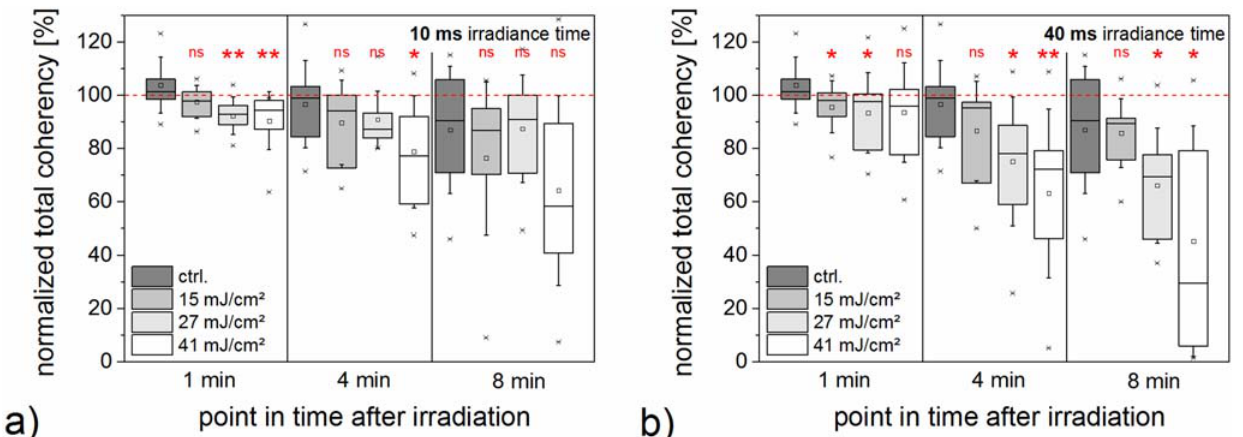
Fig 9. Normalized total coherency of F-actin orientation at distinct points in time after irradiation. Values are normalized to the coherency before laser irradiation. The unirradiated control is based on the same dataset in both diagrams. A disorientation of the F-actin structure is most pronounced for 27 mJ/ cm 2 and 41 mJ/cm 2 at all three points in time. Additionally, the disorientation increases with time, such that the coherency in the irradiated samples decreases. Data of 10 irradiated cells is shown. Whiskers for box plots depict one standard deviation.